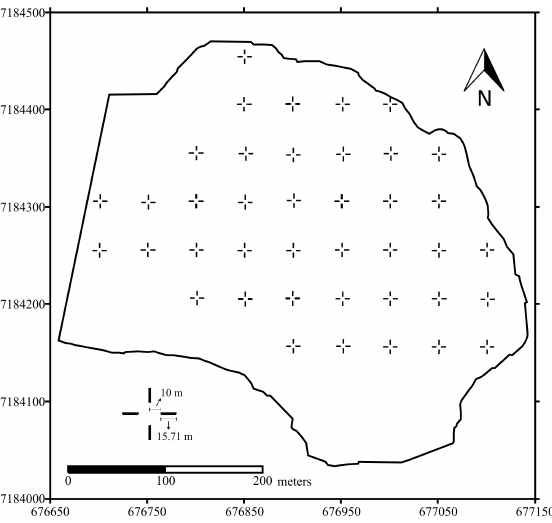
Figure 1 - Systematic clusters allocated in an urban mixed tropical